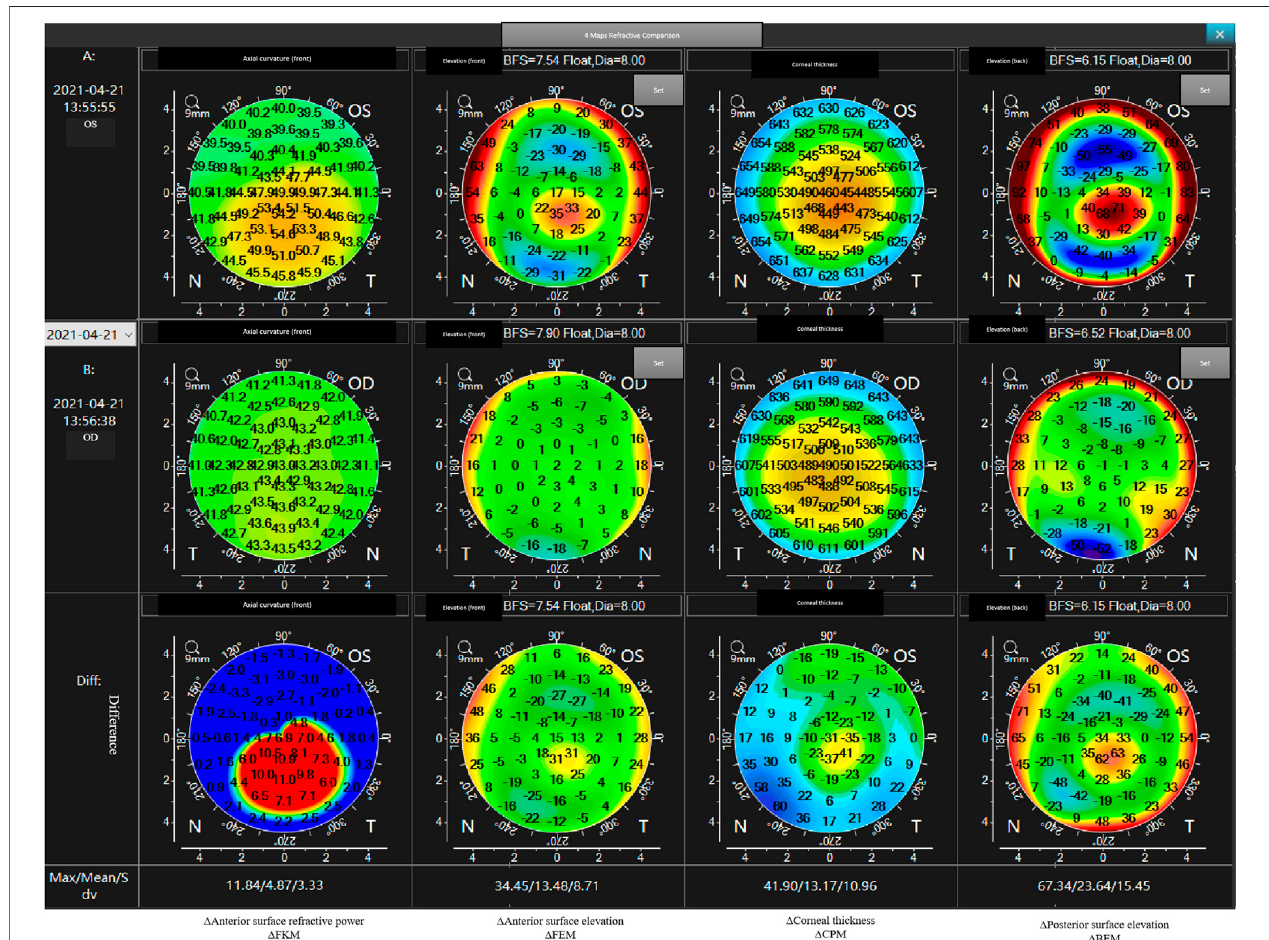
FIGURE 4 | An example of bilateral differential topographic display of a patient with keratoconus.